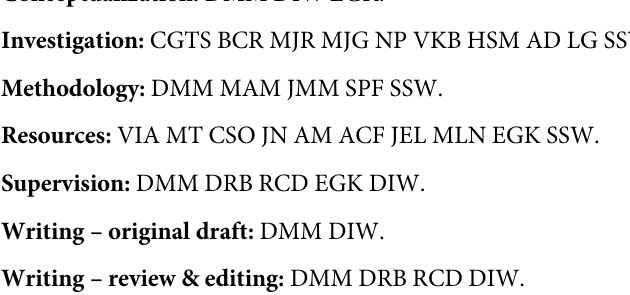
S1 Table. Gene usage and SHM levels in the plasmablast-derived mAbs. S2 Table. Plasma